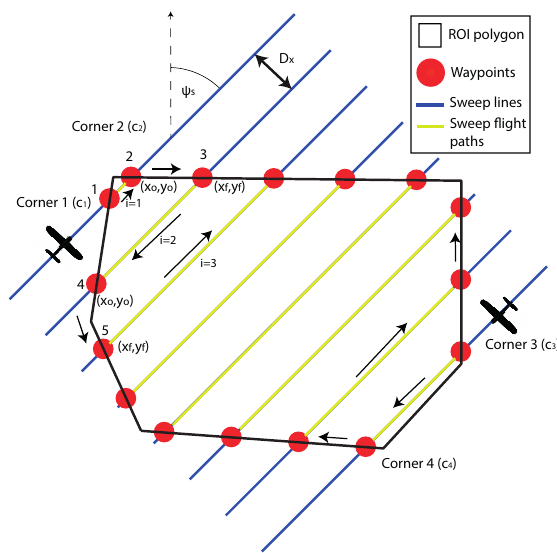
Figure 3. Sweep line intersections with the Region of Interest (ROI) polygon define the straight line waypoints. Showing the order of the traversal of all the sweeps in a convex survey. Additionally, it shows that the survey can start in one of four